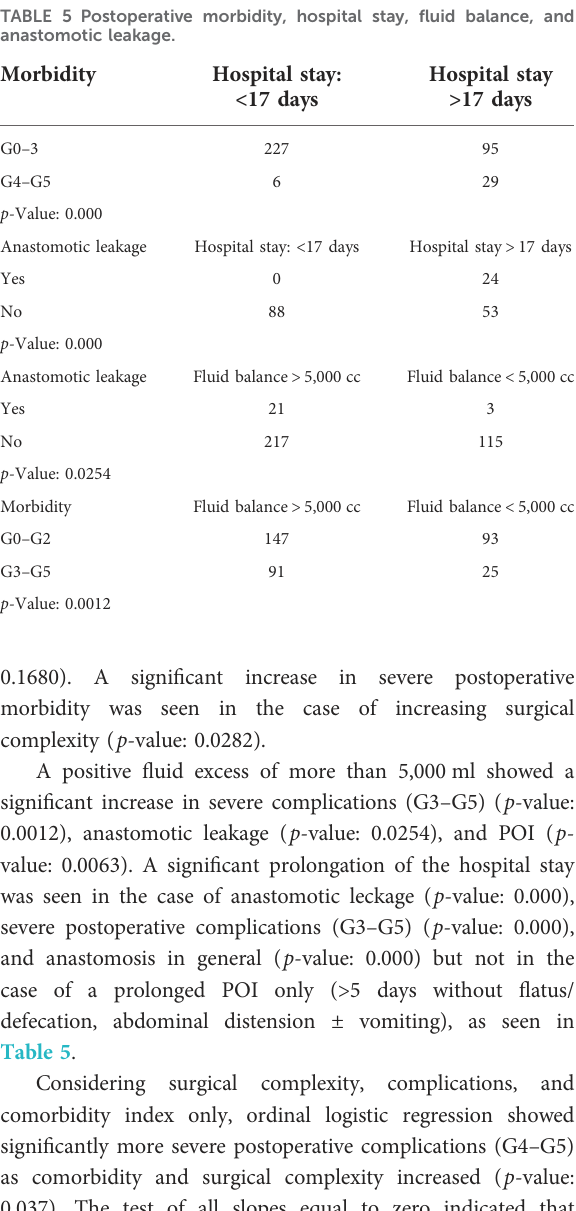
Considering surgical complexity, complications, and